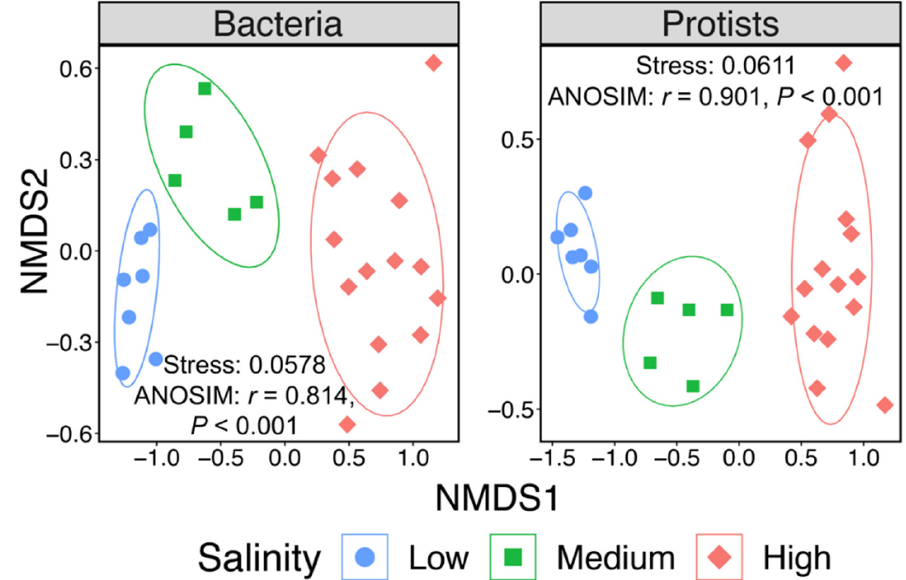
Figure 4. Nonmetric multidimensional scaling (NMDS) plots based on bacterial and protistan beta- diversity dissimilarity (Bray–Curtis). The circle (blue), square (green) and diamond (red) represent sampled sites of low-salinity cluster ( n = 7), medium-salinity cluster ( n = 5) and high-salinity cluster ( n = 15), respectively.